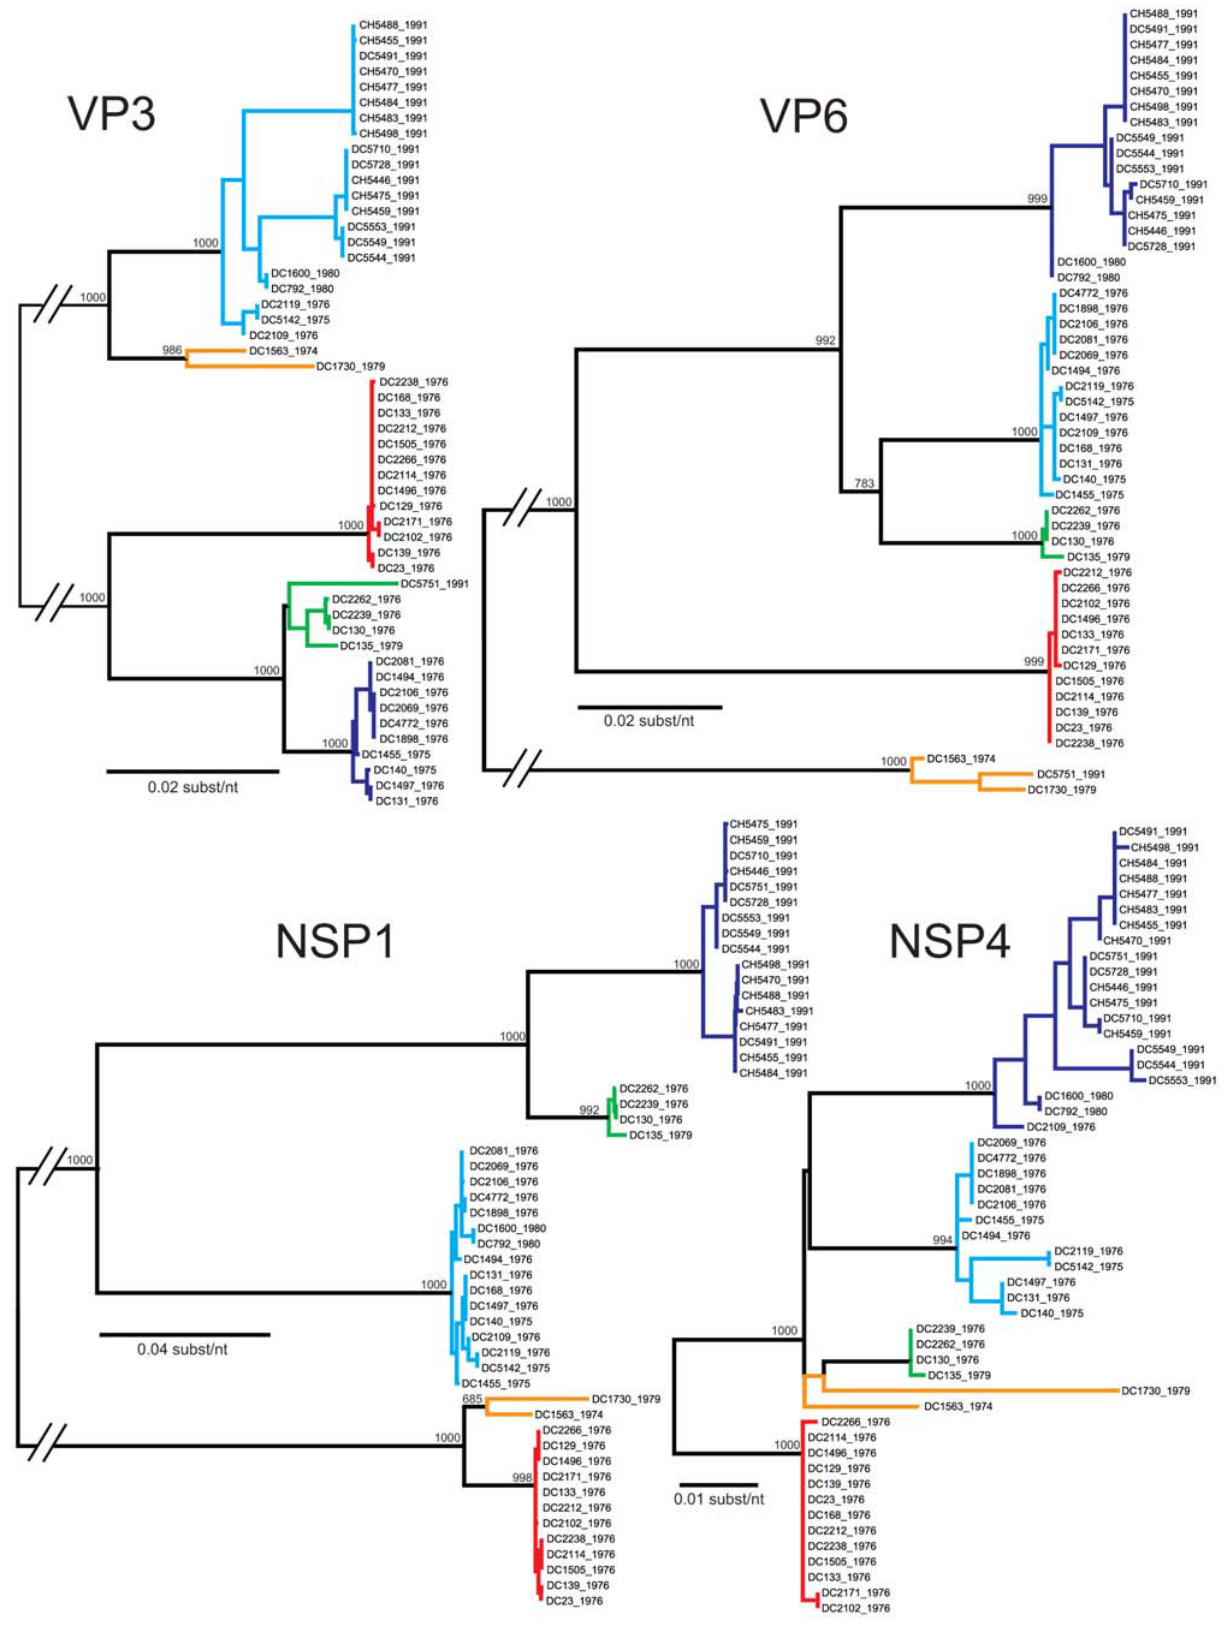
Figure 3. Phylogenetic Relationships Among the Individual Genes of the G3P[8] RVs: VP3, VP6, NSP1, and NSP4. Details are given in the legend for Figure 2. Horizontal branch lengths are drawn to scale, expect for those interrupted with hash bars, which have been truncated.